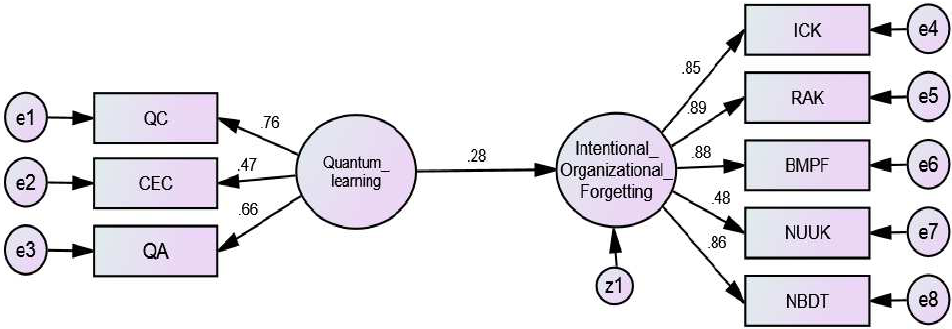
Fig. 6. Standard coefficients of the model